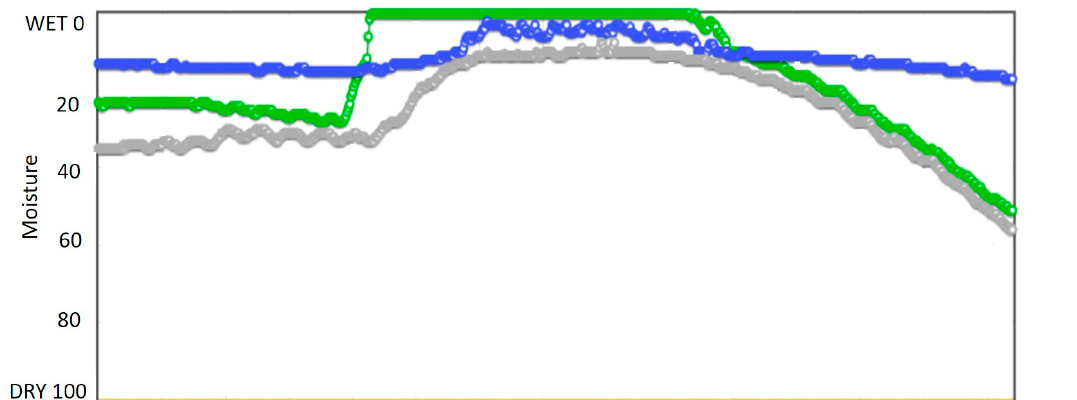
Figure 5. Soil moisture tension (Centibars) at 0.30, 0.60 and 1.20 m deep (12, 24 and 48 inches) in ( A ) surface irrigation (SI); and ( B ) sub-surface drip irrigation (SDI), at the UC Davis experiment for an individual cutting cycle in 2016.